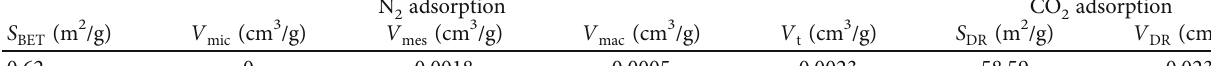
and CO adsorption. 2 2